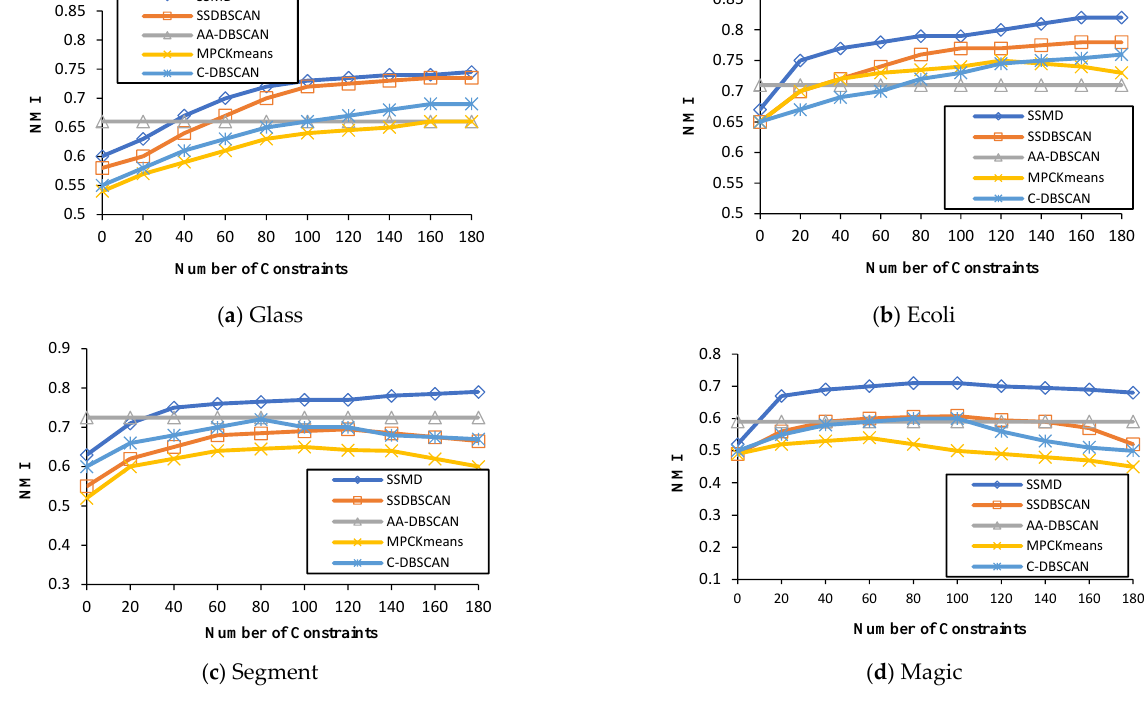
Figure 1. Comparison of NMI.